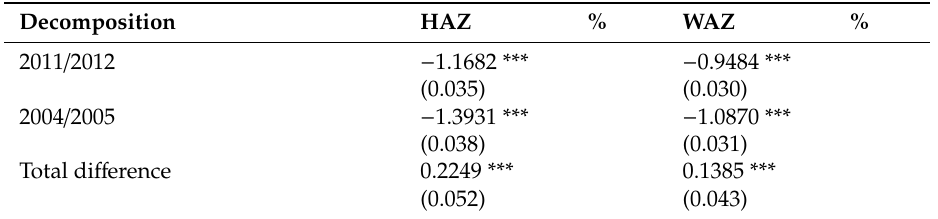
Table 3. Blinder-Oaxaca (BO) decomposition of socio-economic di ff erences in undernutrition among Indian children under five: IHDS 2004 / 2005–2011 /